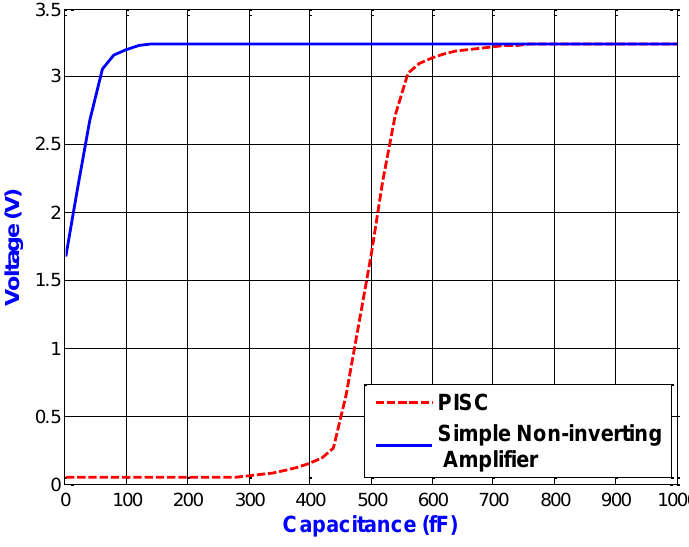
Figure 14. Enlarge picture of the PISC circuit of Figure 13 (460 fF–540